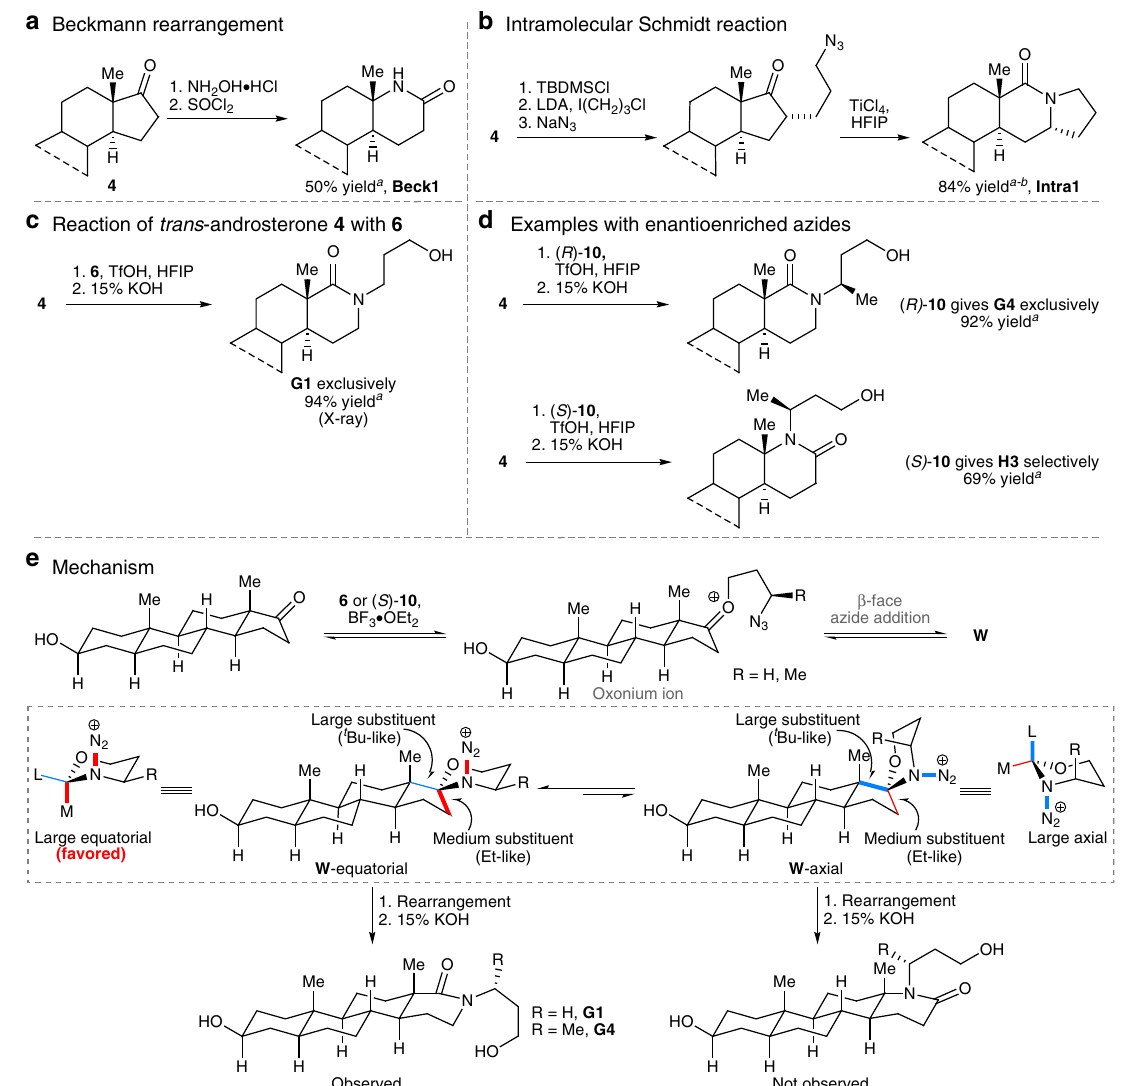
Fig. 3 Regioselective ring expansions of 17-oxosteroids. a Beckmann reaction of a C-17 ketone affords selective migration of C-13. b Forced migration of C- 16 using an intramolecular Schmidt reaction. c Reaction of a 17-oxosteroid with 3-azidopropanol 6 regioselectively results in C-16 migration. d Reactant control of ring expansions of 4 by treatment with 3-azidobutanol ( R )- 10 and ( S )- 10 . e Mechanism considerations of regiochemical outcomes for the reaction using achiral azide 6 in c and chiral reagent ( R )- 10 in d . See Supplementary Methods for full synthetic details. a Isolated yield after chromatography on silica. b Schmidt reaction with concomitant deprotection of protecting group TBDMS. See Supplementary Methods for full synthetic details. G and H series are trans -androsterone derivatives; W , proposed spirocyclic intermediates (two conformers); TBDMS, tert -butyldimethylsilyl; LDA, lithium diisopropylamide 1 M in tetrahydrofuran; TfOH, tri fl uoromethanesulfonic acid; HFIP, hexa fl uoro-2-propanol; 15% KOH, 15% aqueous solution of potassium